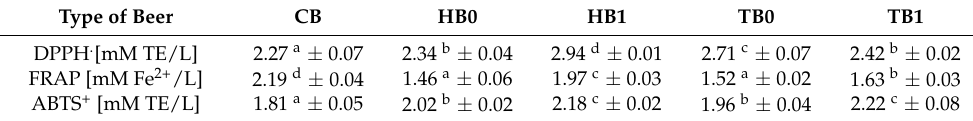
Table 2. Antioxidant potential of fruit beers with Saskatoon berry fruit pulp